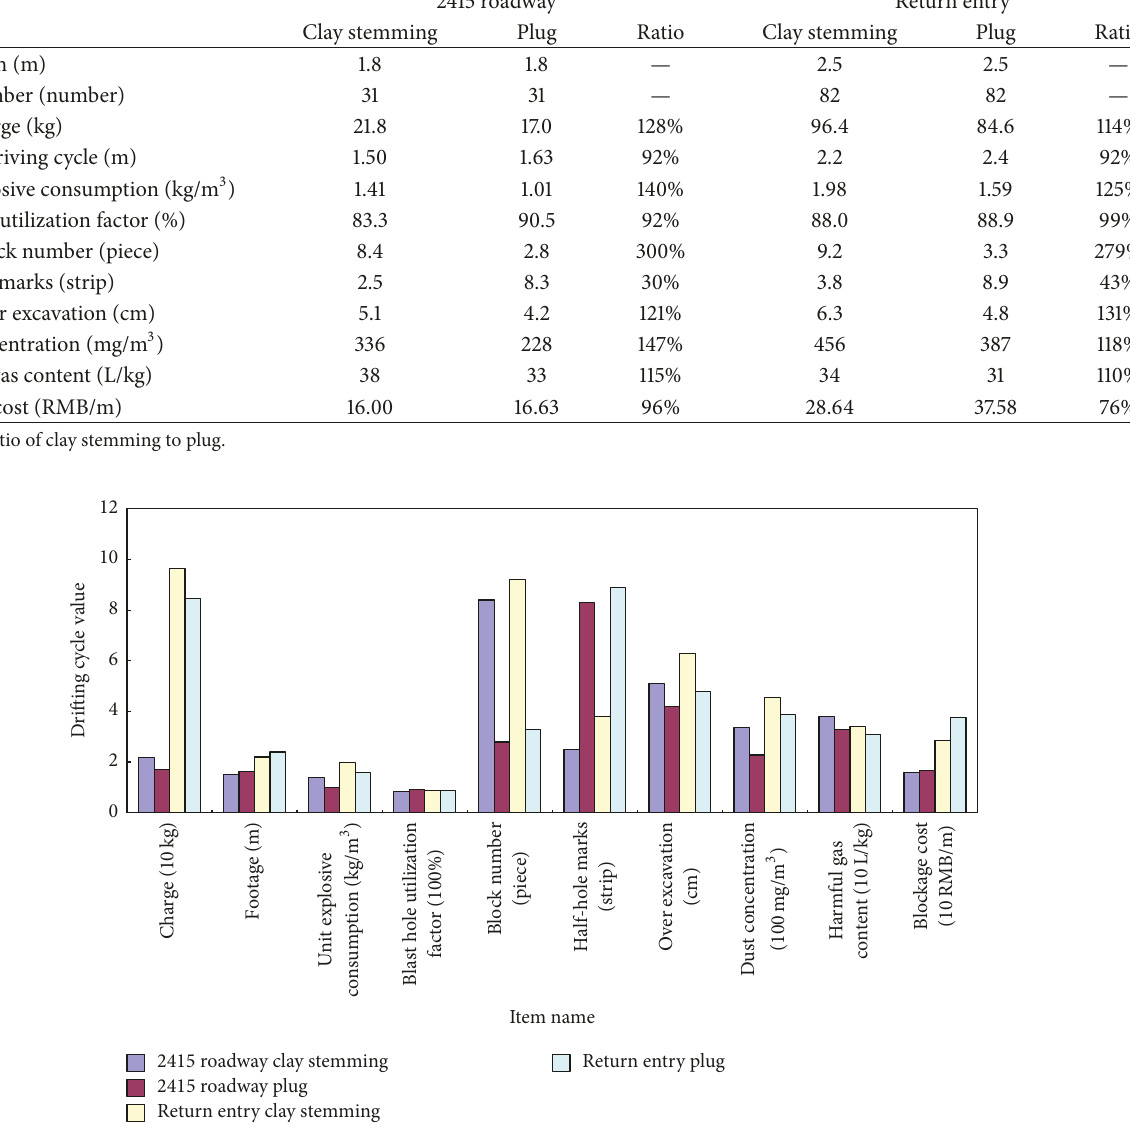
Figure 11: Comparison of blasting effect between traditional clay stemming and new